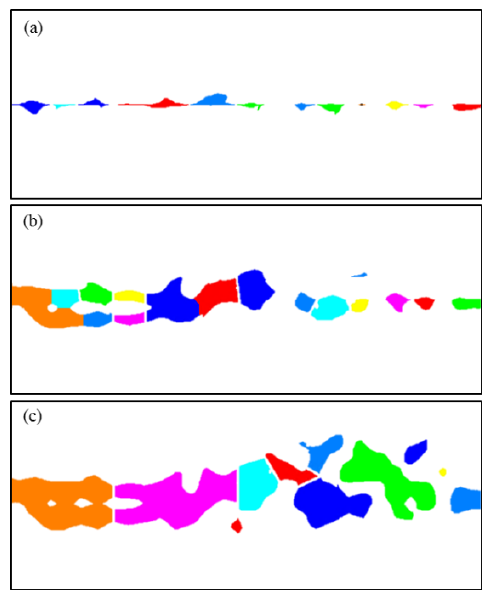
Figure 13. Image processing results showing the cavity segmentation for different matrix permeabilities. The matrix permeability factor C K in ( a ), ( b ), and ( c ) is 1 × 10 −13 m 2 , 1 × 10 −12 m 2 , and 1 × 10 −11 m 2 , respectively. Different colors are used to visually differentiate the individual cavities. Table 5. Statistics of the characteristic parameters for different cross fracture permeabilities.